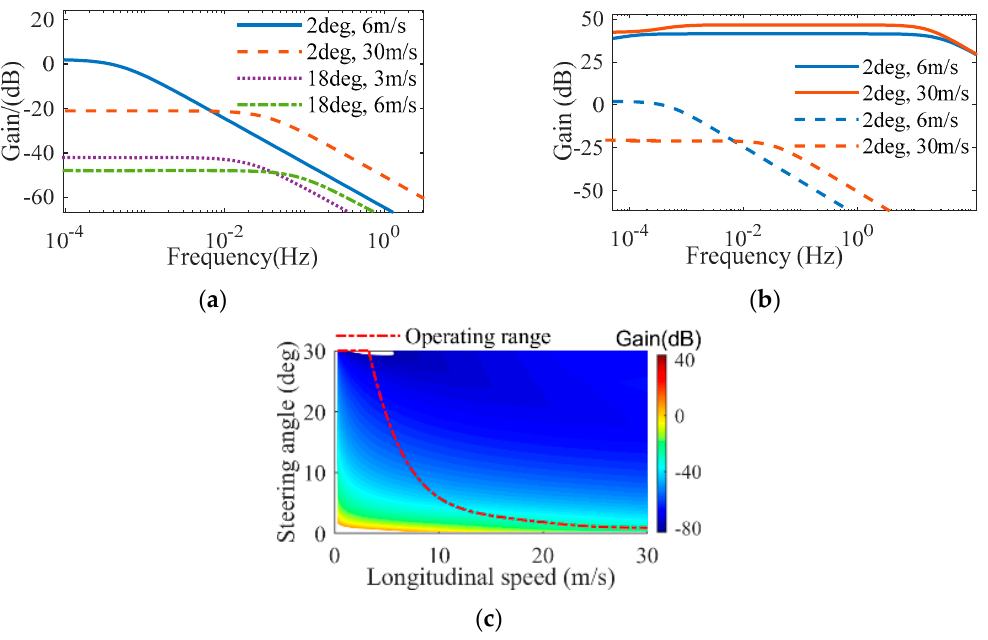
Figure 5. Coupling analysis results of F T on ω . ( a ) Amplitude-frequency characteristics from F T to ω . ( b ) Influences of δ f with respect to F T on ω . ( c ) Open-loop gains from F T to ω